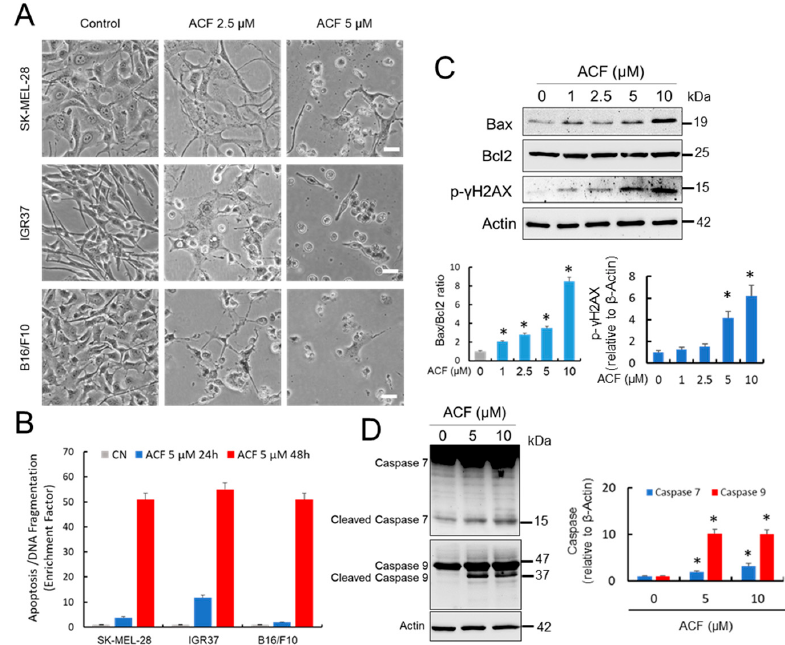
Figure 5. ACF induces apoptotic cell death in melanoma cells. ( A ) Morphological aspect of untreated melanoma cells compared with those subjected to 2-days of treatment with indicated concentrations of ACF (bars, 100 µ M). 40 × magnification ( B ) Apoptosis determination at different ACF concentrations in indicated melanoma cells after 24 and 48 h of treatment. Data were obtained in triplicate in two independent experiments. Differences in apoptosis in ACF-treated cells were significant with respect to untreated controls for each drug concentration and at any time ( p < 0.05). ( C ) Western blots showing the effect of ACF on Bax, Bcl2, and p- γ H2AX proteins. SK-MEL-28 cells were treated with different concentrations of ACF for two days. The ratios between Bax and Bcl2 and relative p- γ H2AX are presented in the histograms (* p < 0.05 when compared with the untreated control). ( D ) Western blot analysis of caspase 7 and caspase 9 in the control SK-MEL-28 cells and those treated with indicated doses of ACF. IOD quantification is shown (histogram; * p < 0.05 when compared with their respective untreated